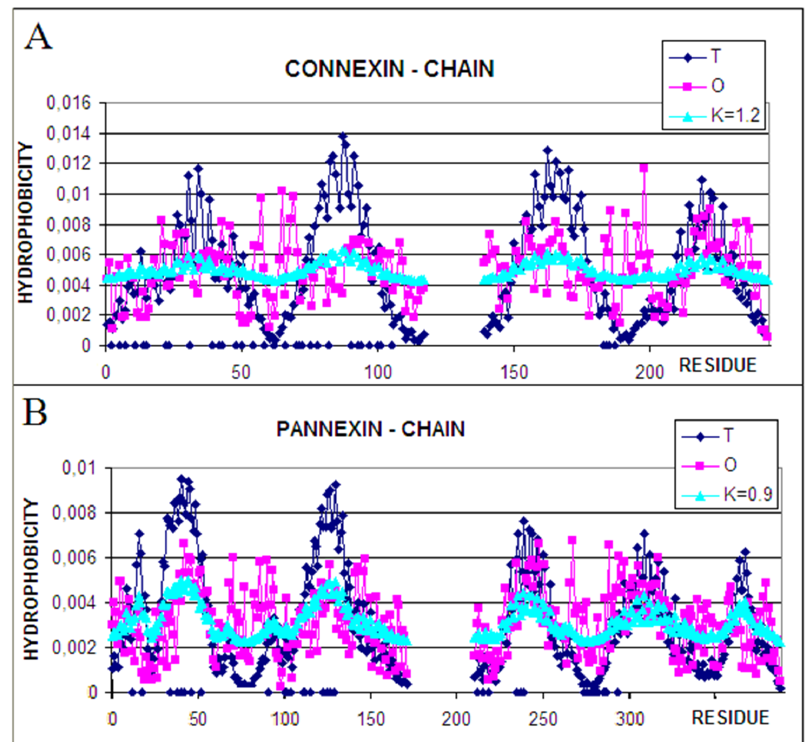
Figure 4. Profiles for the T (dark blue), O (pink), and M (turquoise) distributions were calculated for single chain ( A )—connexin, ( B )—pannexin. Blue dots—bottom line—residues interacting with adjacent